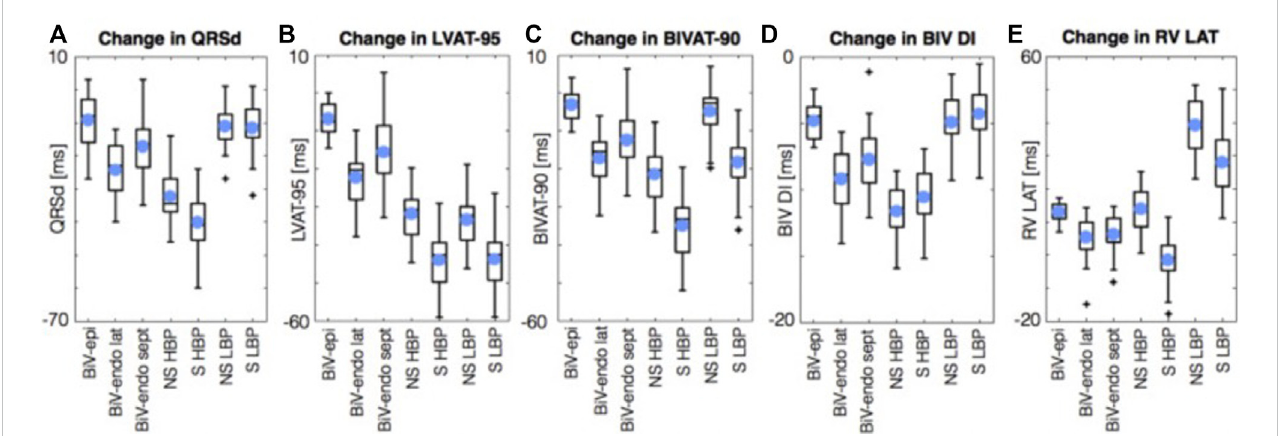
FIGURE 3 Simulations results using 24 four chamber heart meshes. Boxplots of the change in QRSd, (A) LVAT-95, (B) BIVAT-90, (C) BIV DI (D) , and RV LAT (E) from baseline with BiV-epipacing attheoptimal location, BiV-endo lateralpacing attheoptimal location, BiV-endo septal pacing (BiV-endo sept), S- and NS-HBP, and S- and NS-LBP. Light blue circles represent mean values. Plus symbols represent outliers. BiV, biventricular; BIV DI, biventricular dyssynchronous index; BIVAT-90, 90% biventricular activation time; endo, endocardial; epi, epicardial; HBP, His-bundle pacing; LAT, lateral; LBP, left bundle pacing; LV, left ventricle; LVAT-95, 95% left ventricular activation time; NS, non-selective; QRSd, QRS duration; RV LAT, right ventricular latest activation time; S, selective; sept, septal. Reproduced from reference 55, Strocchi et al., with